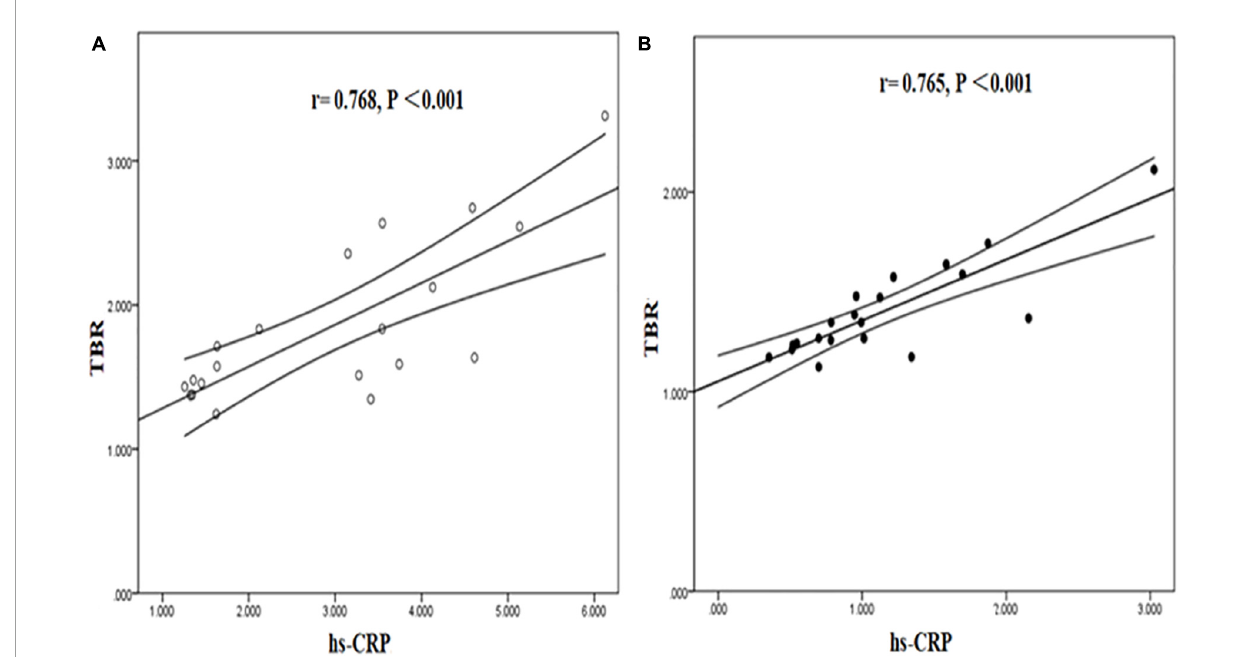
FIGURE7 Correlation between hs-CRP and TBR in symptomatic and asymptomatic patients. The correlation between hs-CRP and TBR values was significantly positive in symptomatic (A) and asymptomatic group (B) .